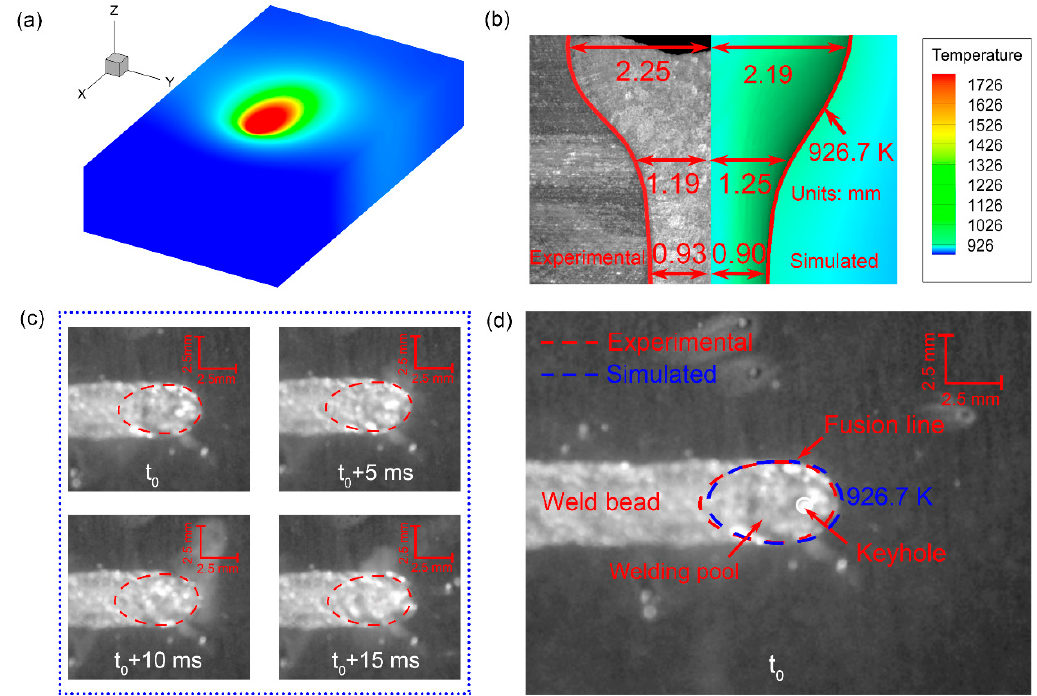
Figure 9. ( a ) Temperature contour from heat transfer calculation; ( b ) comparison of fusion profiles between the experimental and simulated results; ( c ) evolution of laser welding pool with time proceeding captured by the high-speed camera; ( d ) comparison between the experimental results with the simulated results (here the simulated fusion profile (isotherm 926.7 K) was converted into the same scale as the high-speed camera image).